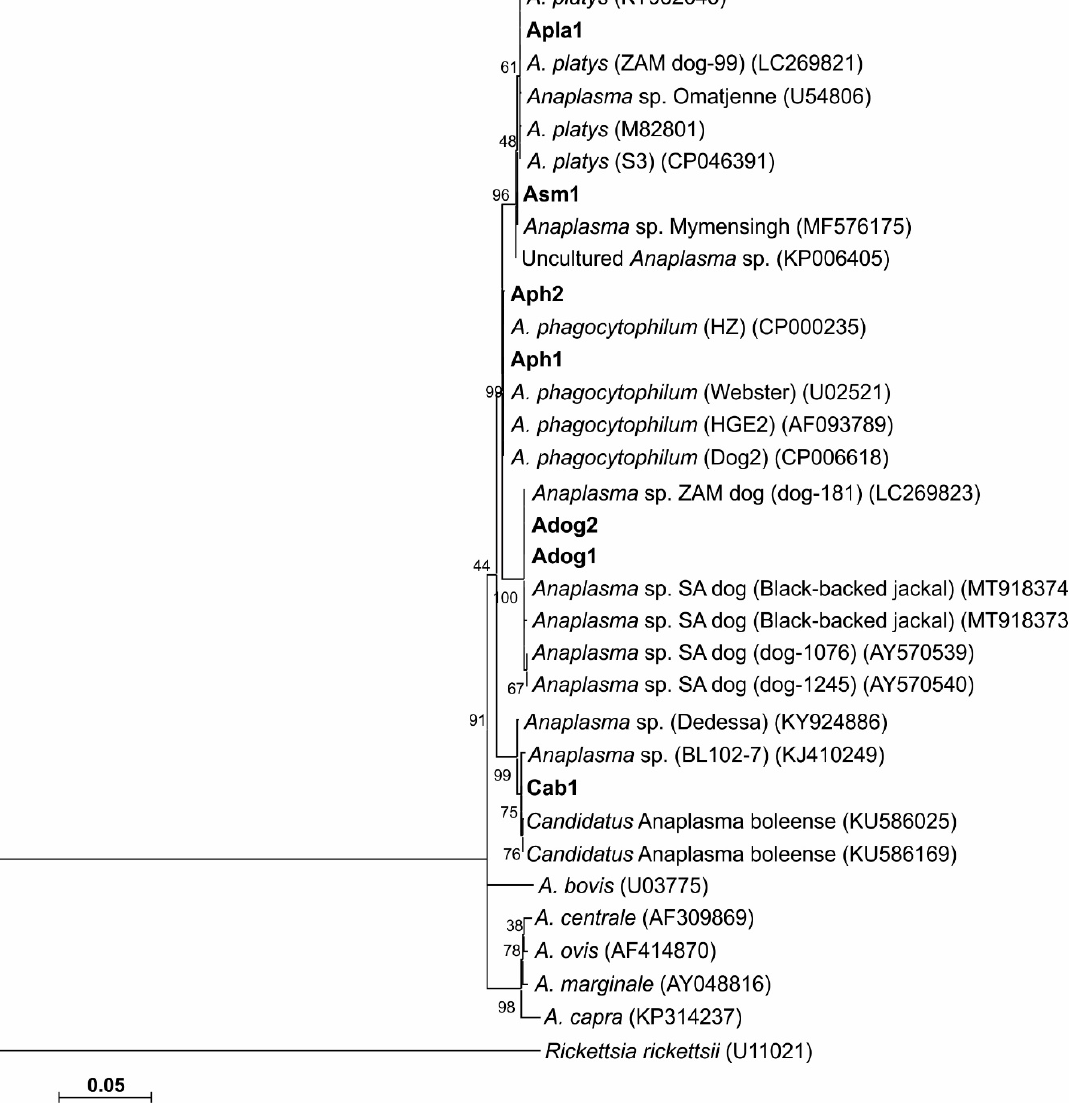
Figure 2. Maximum likelihood phylogenetic tree based on 16S rRNA nucleotide sequences in an alignment truncated to 1195 nt. The tree shows the phylogenetic relationship between the 16S rRNA gene sequence variants obtained in the study and related Anaplasma species. The 16S RNA variants were designated as A. phagocytophilum Aph1 and Aph2, Anaplasma sp. ZAM dog Adog1 and Adog2,